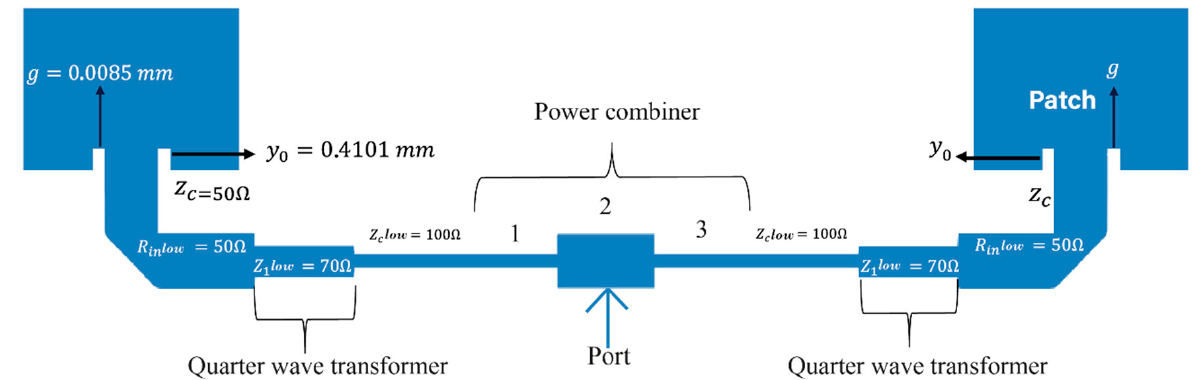
Figure 6. 1×2 array of square patch antenna with inset feed. Figure 6. 1 × 2 array of square patch antenna with inset feed.